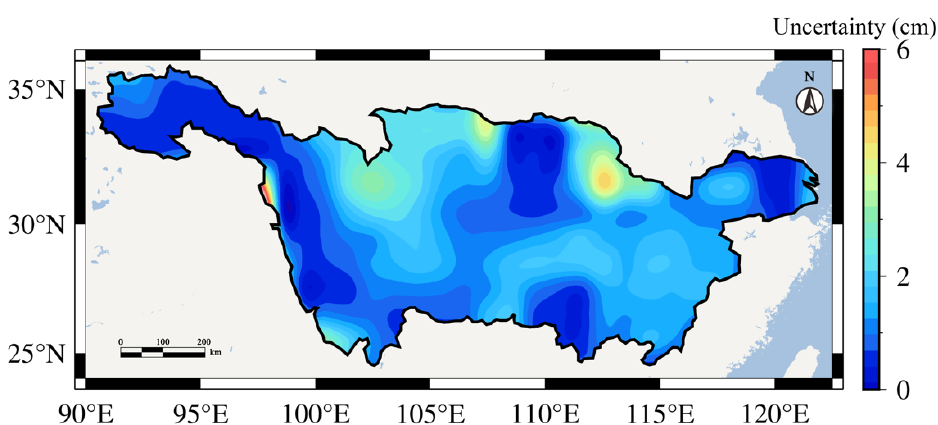
Figure 3. The spatial distribution of uncertainties of fused TWSC results in the YRB.